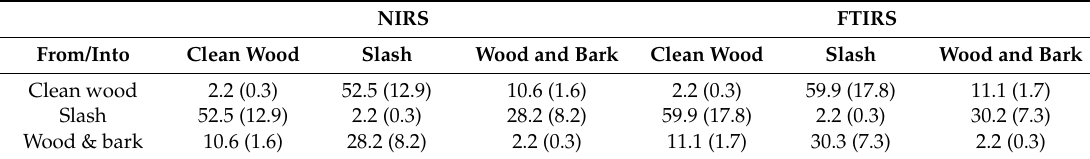
Table 3. Generalized squared distances of the three plant part components of forest logging residue. NIRS FTIRS